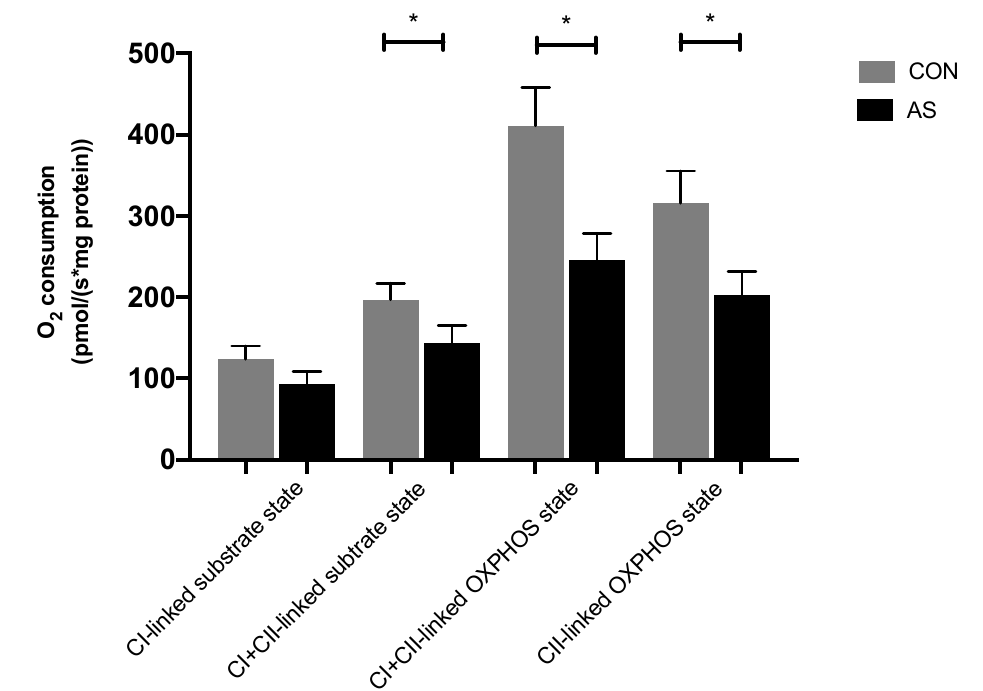
Figure 2. Oxidative capacity and activity of respiratory chain complexes in cardiac muscle in CON compared with AS group. CON: control group; AS: anaphylactic shock group; CI: mitochondrial complex I; CI + II: mitochondrial complexes I and II; OXPHOS: mitochondria ADP-activated state of oxidative phosphorylation, CII: mitochondrial complex II. Values are means ± SEM, * p < 0.05. There was no significant difference in non-phosphorylating respiration with activa- tion of complex I alone (CI-linked substrate state) between CON and AS groups, respec- tively: 124 ± 16 vs. 93 ± 15 pmol/s/mg, p = 0.18. However, myocardial mitochondrial CI + II-linked substrate state was significantly decreased in the AS group: CI + II-linked substrate state ( − 27%, 197 ± 21 vs. 144 ± 21 pmol/s/mg, p < 0.05; in CON and AS groups, re- spectively).